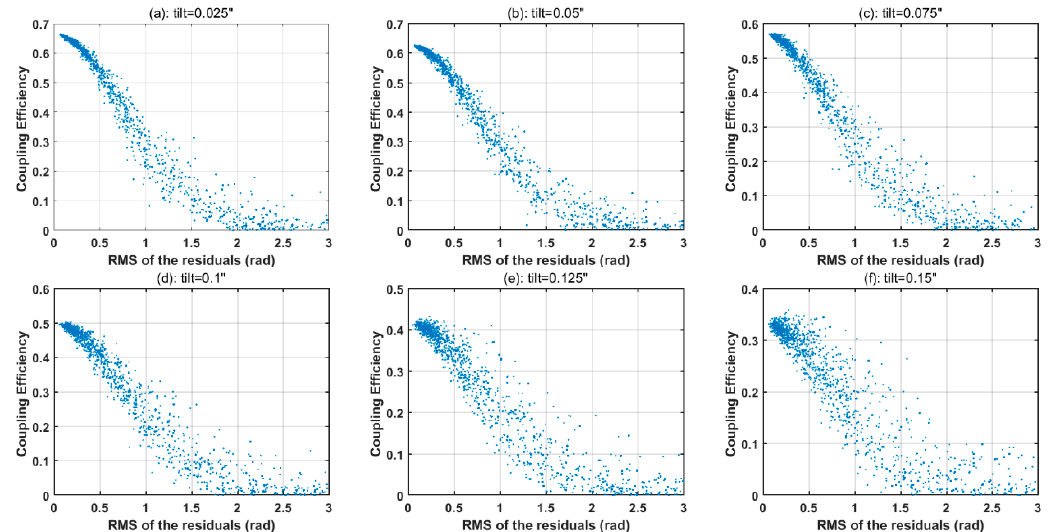
Figure 6. Relation between CE and root-mean-square (RMS) of residual wavefront with different tilt biases. ( a ) Tilt = 0.025 arc-second; ( b ) tilt = 0.05 arc-second; ( c ) tilt = 0.075 arc-second; ( d ) tilt = 0.1 arc-second; ( e ) tilt = 0.125 arc-second; ( f ) tilt = 0.15 arc-second.